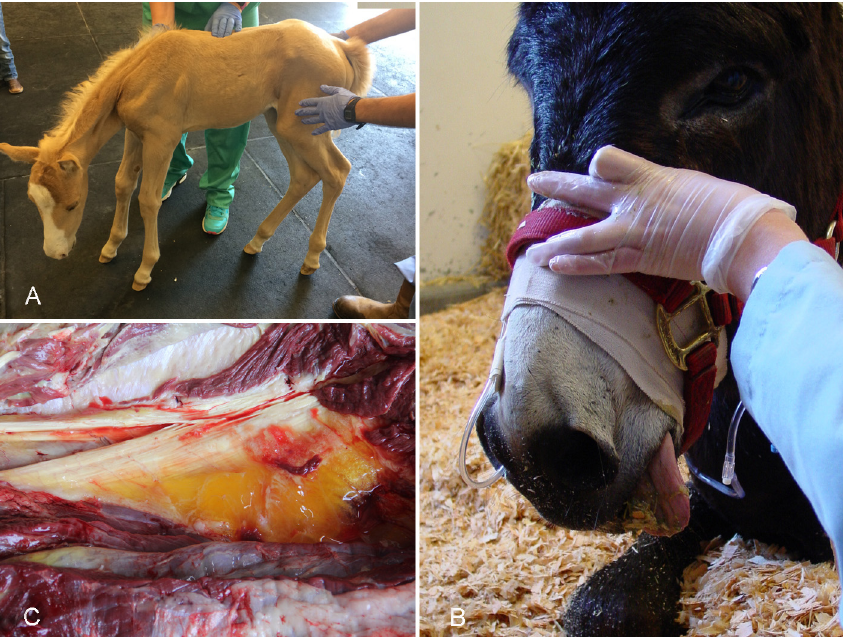
Figure 7. Botulism. ( A ) Foal showing muscle weakness, leading to inability to keep its head up and needing help to stand (photo courtesy of Gary Magdesian). ( B ) Adult horse with decreased muscle tone of the tongue, which is protruding outside the mouth (photo courtesy of Nicola Pusterla). ( C ) Neck of an adult horse showing gelatinous edema surrounding the nuchal ligament.